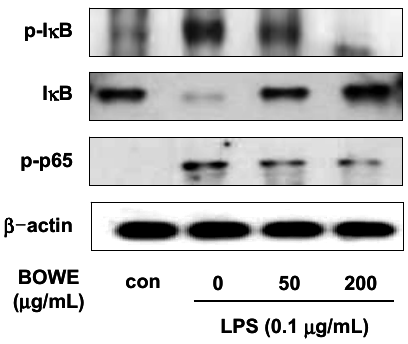
Figure 5. Effect of BOWE on I κ B- α and NF- κ B p65 phosphorylation in LPS-stimulated BV-2 cells: BV-2 cells were pretreated with or without the indicated concentrations of BOWE for 4 h and then stimulated with LPS (0.1 μ g/mL) for 18 h. The cellular proteins from the cells were used for the detection of phosphorylated forms of I κ B- α and NF- κ B p65 by western blotting. β -actin was used as a loading